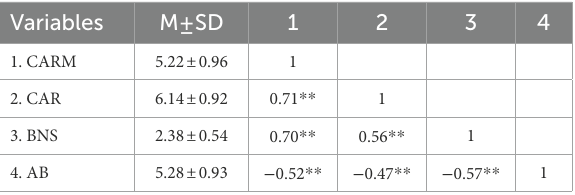
TABLE 1 Descriptive statistics and correlation